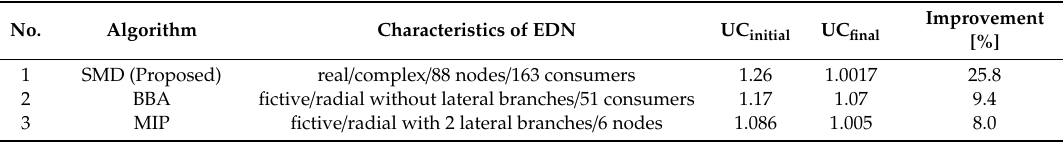
Table 11. Comparison with the linear programming models.